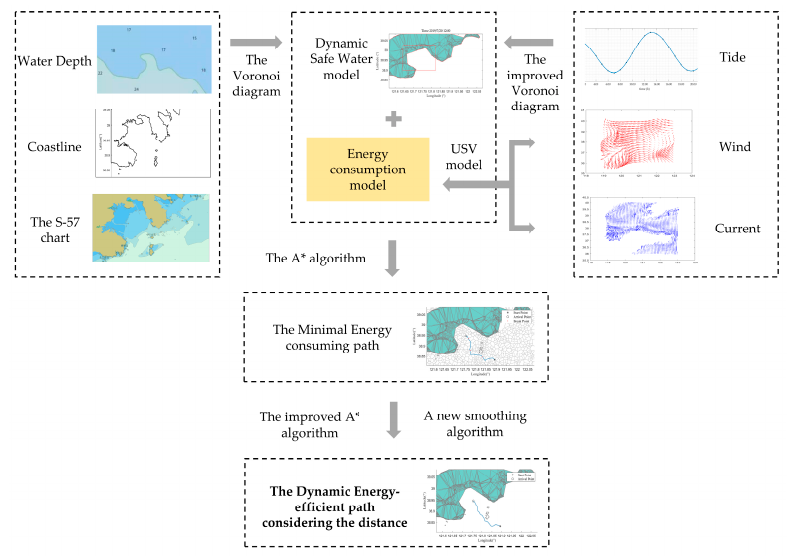
Figure 3. The proposed dynamic energy-efficient path planning architecture considers the distance algorithm. distance